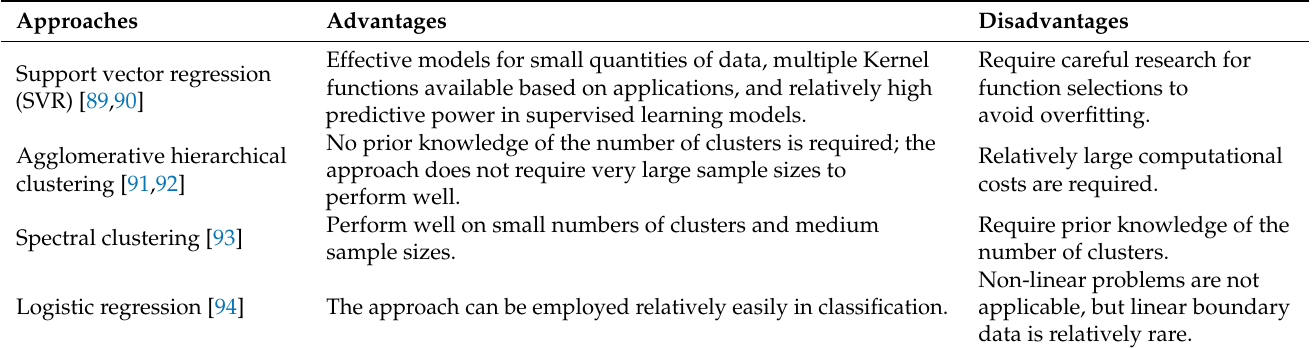
Table 1. Algorithms and approaches used in the literature and their